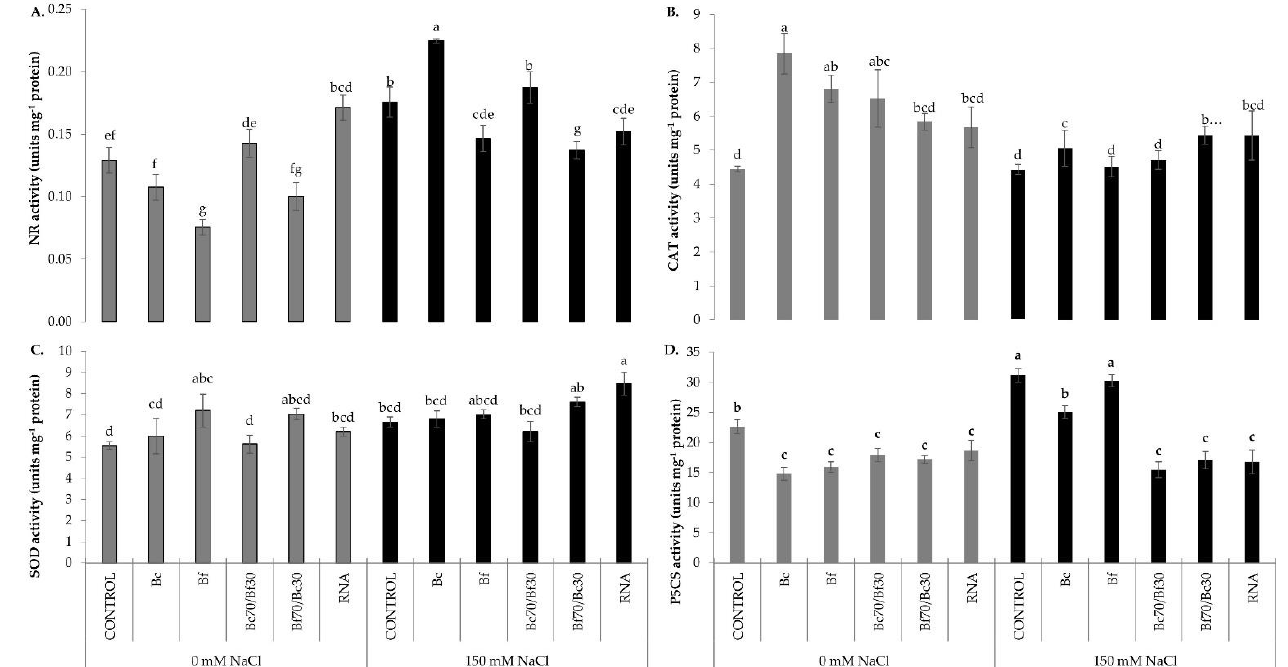
Figure 5. Effect of biostimulant treatments on NR, CAT, SOD, and P5CS enzymatic activity in control (0 mM) and salt-stressed (150 mM) conditions. ( A ) NR enzymatic activity, ( B ) CAT enzymatic activity, ( C ) SOD enzymatic activity, ( D ) P5CS enzymatic activity. Data are means ± SE of three replications. Bars with different letters are significantly different ( p < 0.05). Treatment abbreviations are explained in Figure 1.